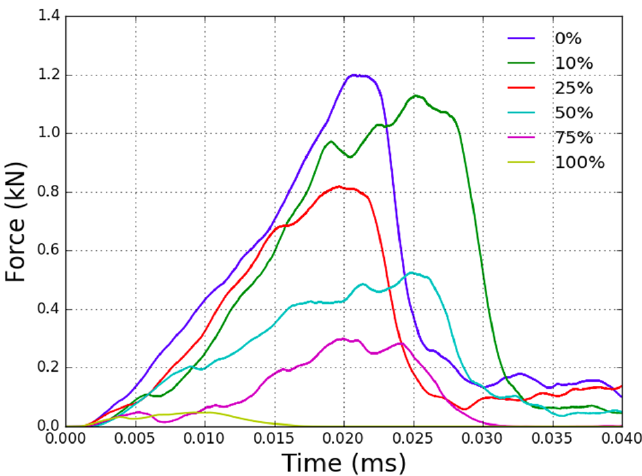
Figure 16. Force-time history of the representative specimen at different percentage grade compo- sition.